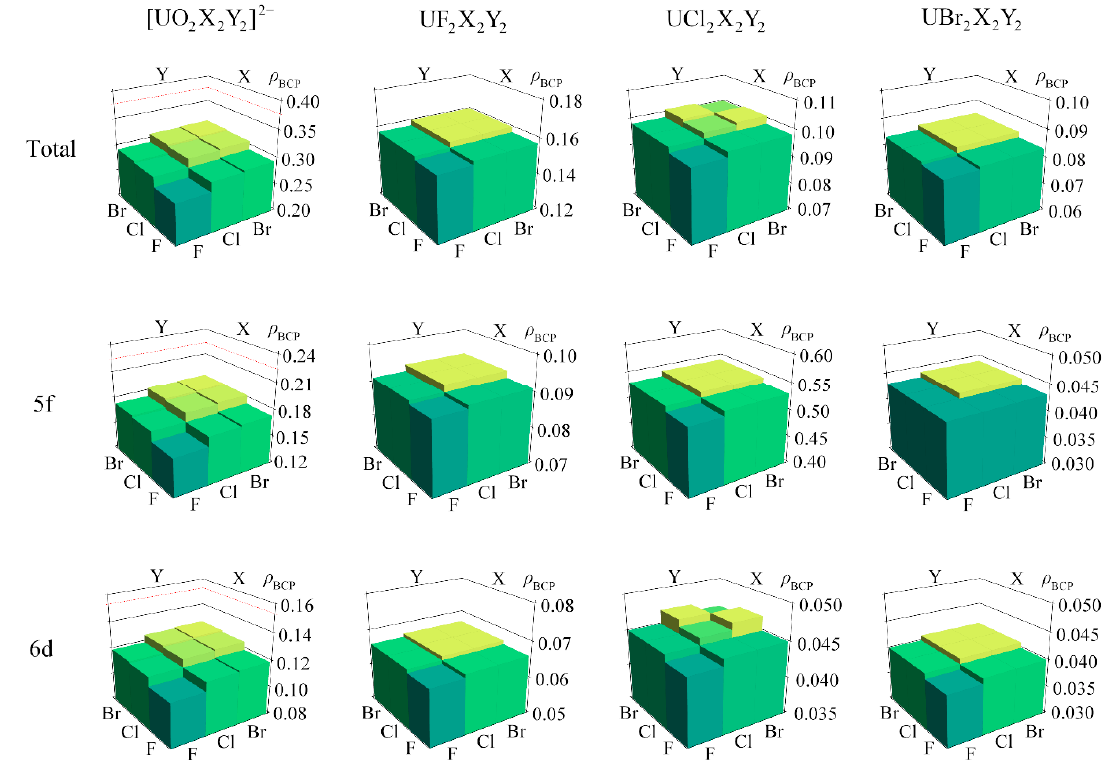
Figure 4. ρ BCP values of axial U–O and U–X (X = F, Cl, Br) bonds in [UO 2 X 2 Y 2 ] 2 − and UX 2 Y 2 Z 2 complexes derived from B3LYP-generated densities. All values are in a.u.